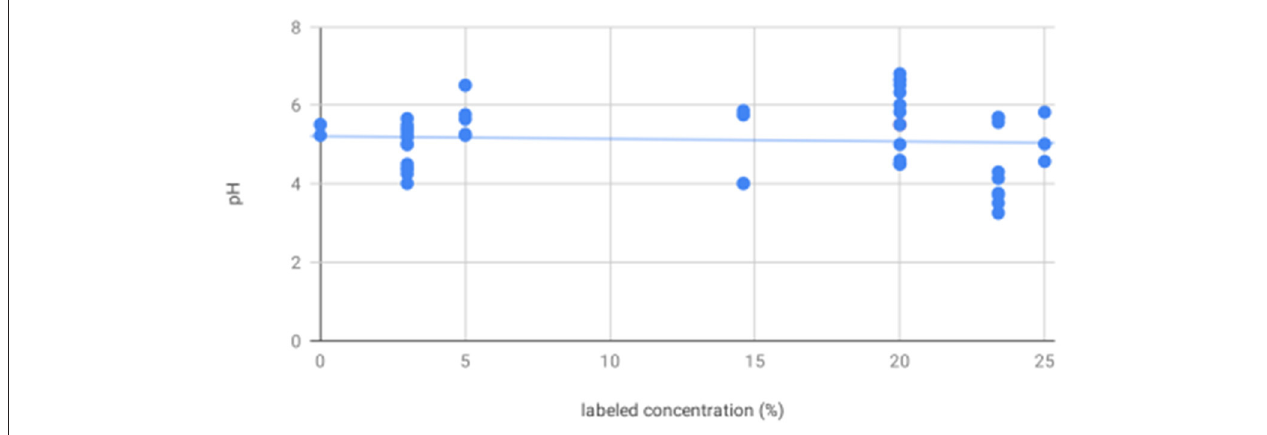
FIGURE 1 | There is no association between labeled solution concentration and pH—scatter plot showing pH as measured by digital pH meter and litmus paper for all solutions shows no significant trend in pH as a function of increasing labeled solution concentration.